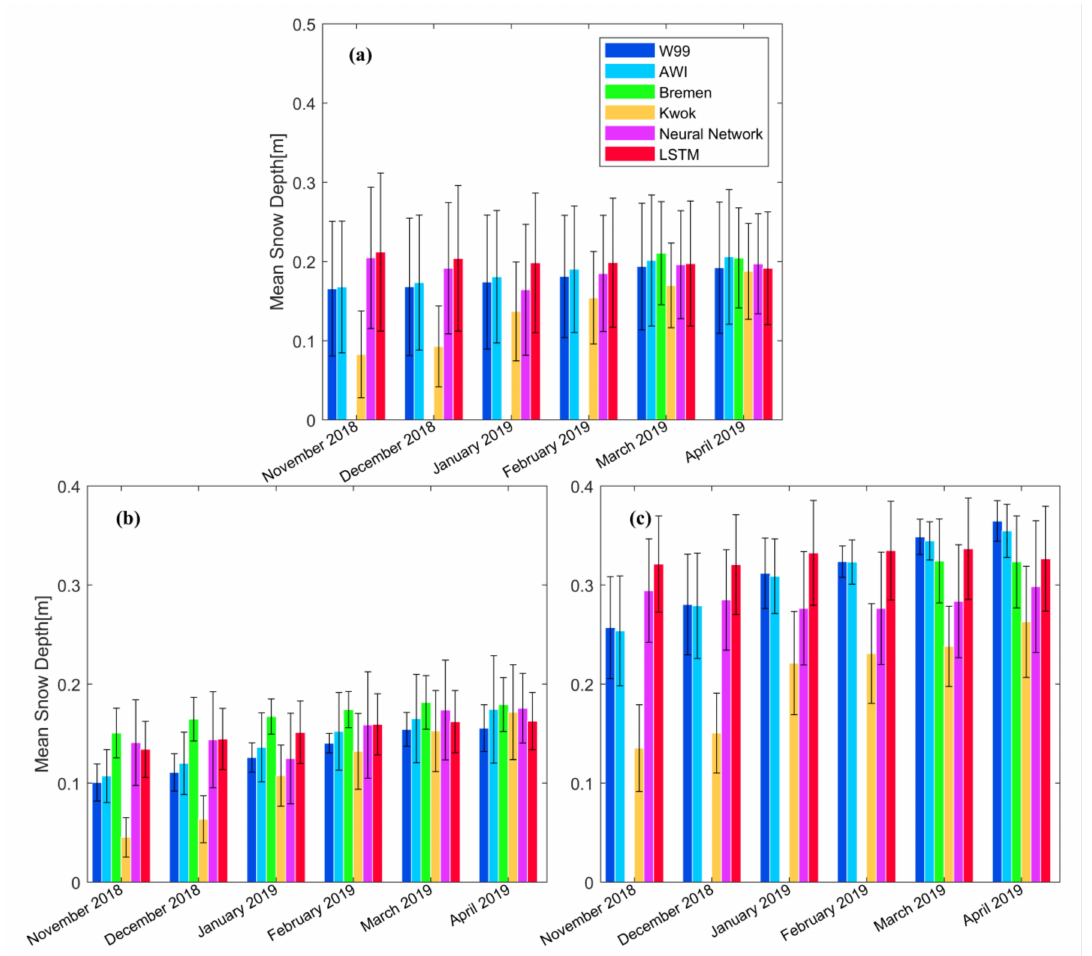
Figure 8. Histogram of seasonal variations in the different snow depth products over the common area of all data sets: ( a ) snow depth on total sea ice, ( b ) snow depth on FYI, ( c ) snow depth on